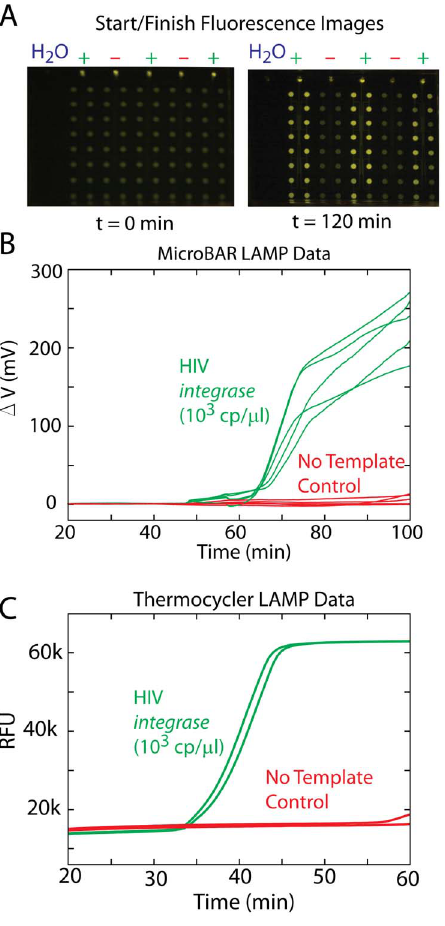
Figure 6. m BAR LAMP vs. Thermocycler LAMP. Results of the LAMP reaction for detection of the HIV integrase gene using both the m BAR and a conventional thermocycler. (A) Presence of the HIV integrase gene target results in an increase in fluorescence from the reaction wells, as seen in these before and after chip photos. (B) Photoamplifier voltages from 5 independent reaction wells are displayed here, all showing a positive result after about 70 minutes. (C) The same assay run on a conventional thermocycler shows positive results slightly faster (40 minutes), possibly due to the differences in assay volumes and thermal transfer